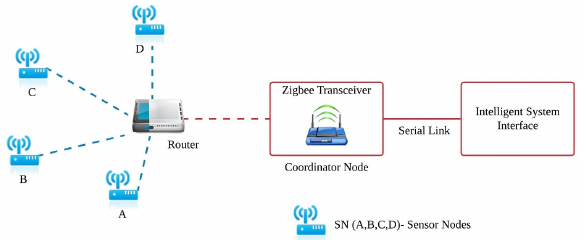
Figure 2: Functional structure of industrial wireless sensor